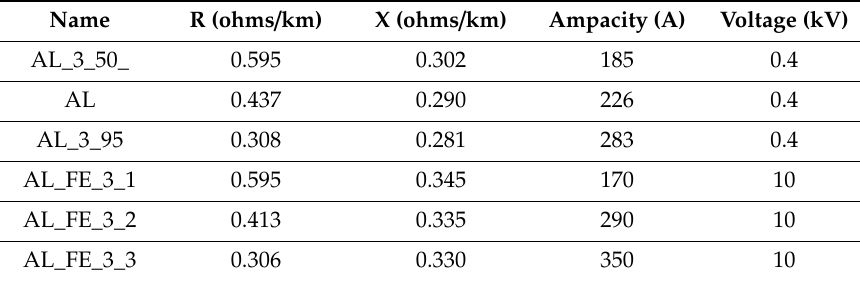
Table A1. Overhead lines’ characteristics.